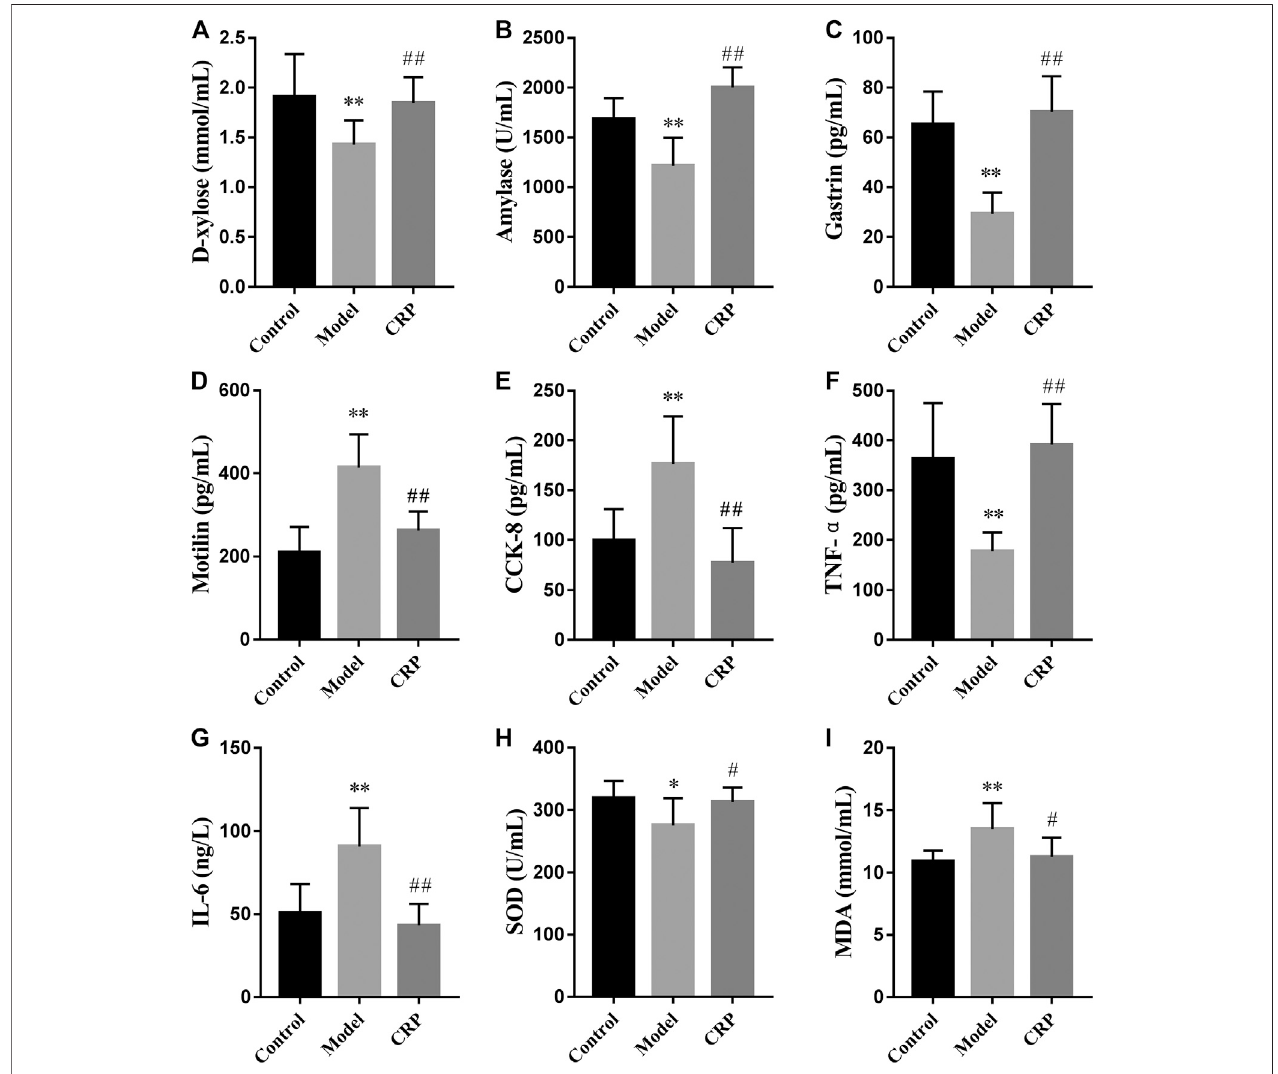
FIGURE 2 | Effects of CRP on biochemical parameters in serum, including the concentrations of (A) D-xylose and (I) MDA, the activities of (B) amylase and (H) SOD, the levels of (C) gastrin, (D) motilin, (E) cholecystokinin-8, (F) TNF- α and (G) IL-6 ( n (cid:2) 10; * p < 0.05, vs. control group; ** p < 0.01, vs. control group; # p < 0.05, vs. model group; ## p < 0.01, vs. model